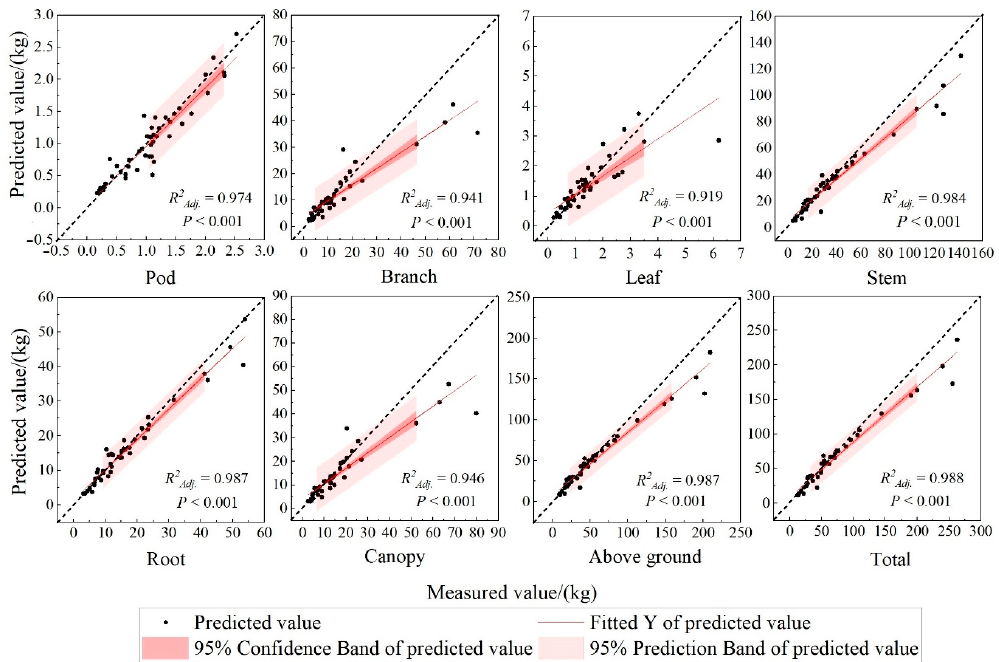
Figure 6. Scatter plot of the predicted and actual biomass values of each component with the best model, system 3. The solid red line refers to the fitting line between the measured values and predicted values. The dark red area is a 95% confidence interval, and the light red area is a 95% prediction interval. The dashed line in black color indicates the 1:1 equivalence.